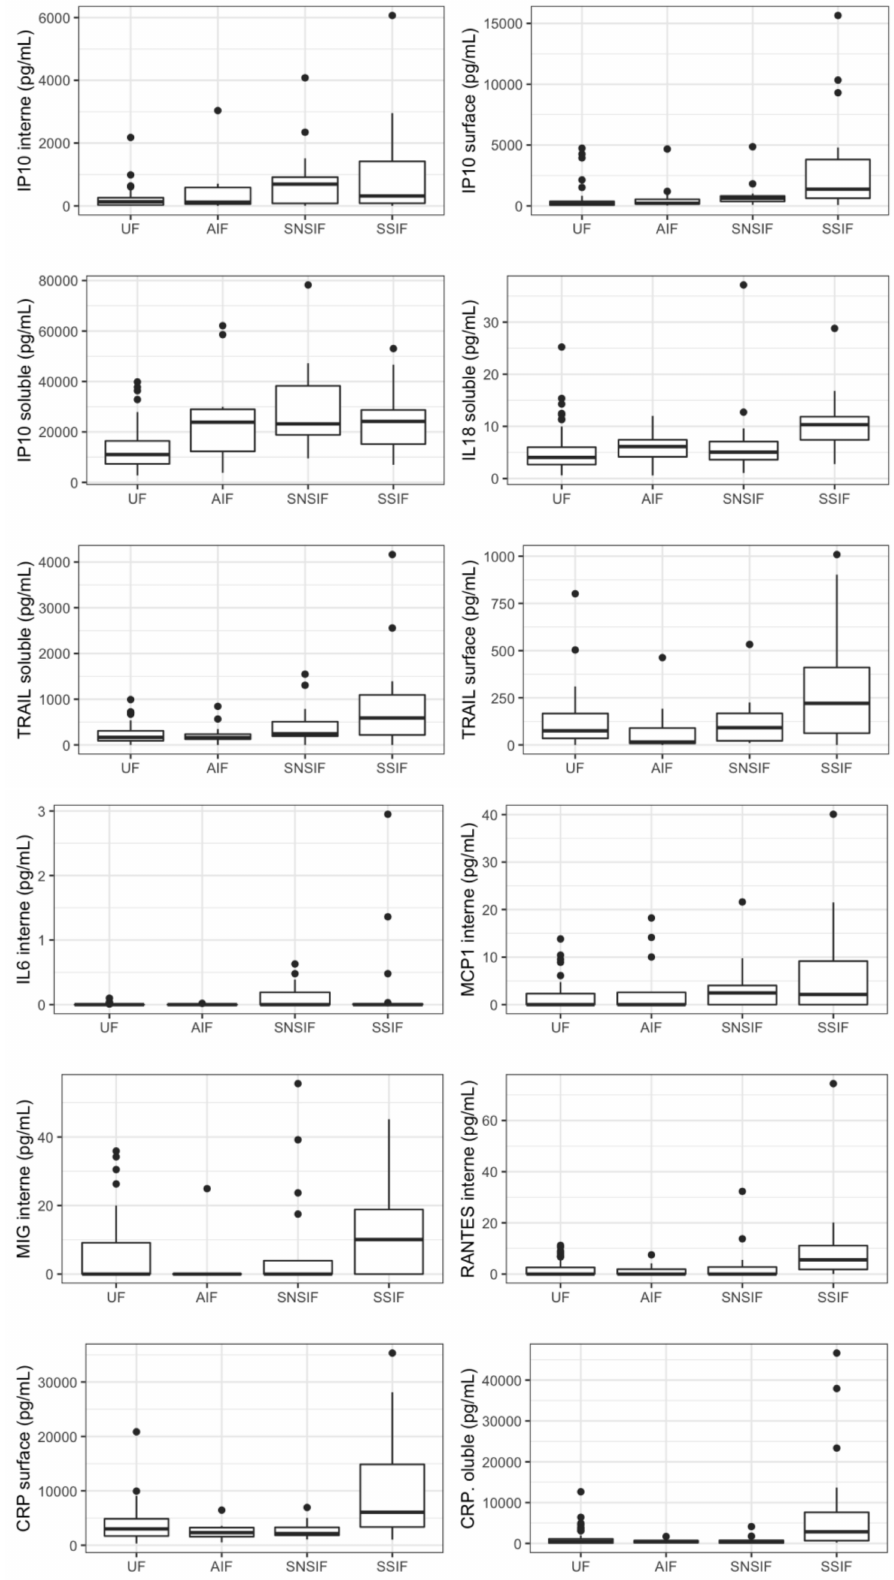
Figure 2. Concentrations of relevant cytokines according to symptomatic state at birth and severity. Boxplots representing represent variations in cytokines’ concentrations (median). UF: unifected fetuses, AIF: asymptomatic infected fetuses, SNSIF: symptomatic and non-severe infected fetuses, SSIF: symptomatic and severe infected